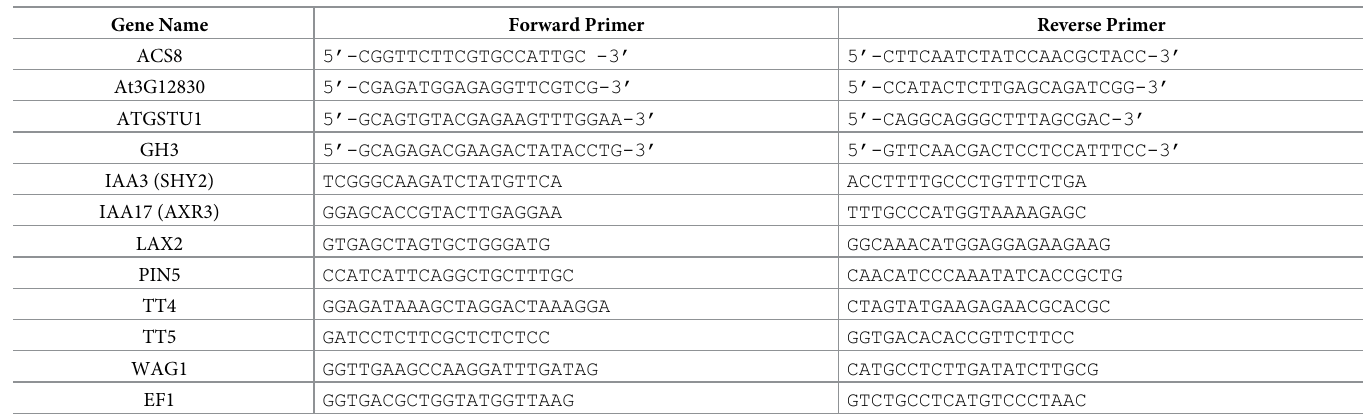
Table 1. Primer pairs of all mutant lines and control gene used in the